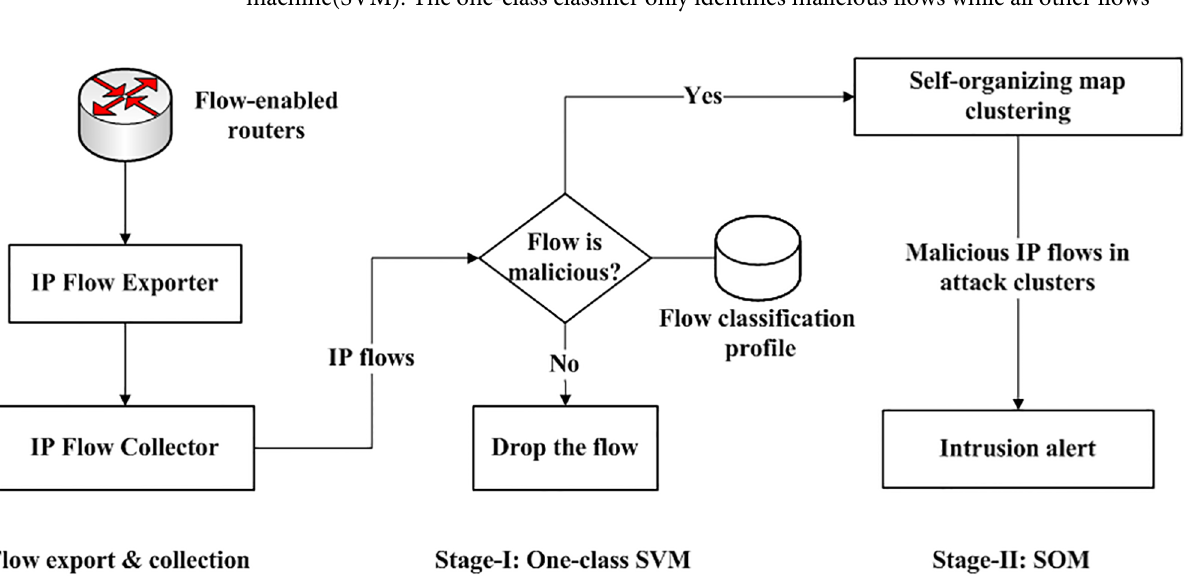
Fig 3. Architecture of two-stage flow-based intrusion detection